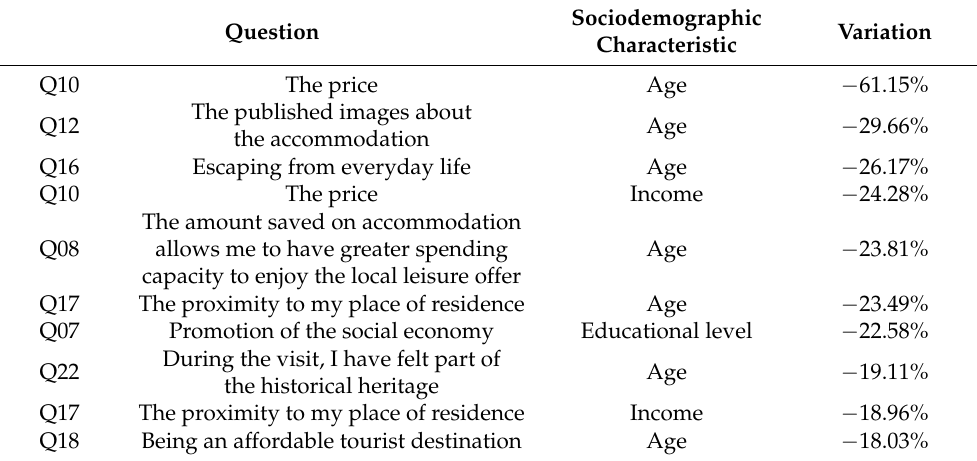
Table 7. Questions with the most inverse influence in profiles’ sociodemographic